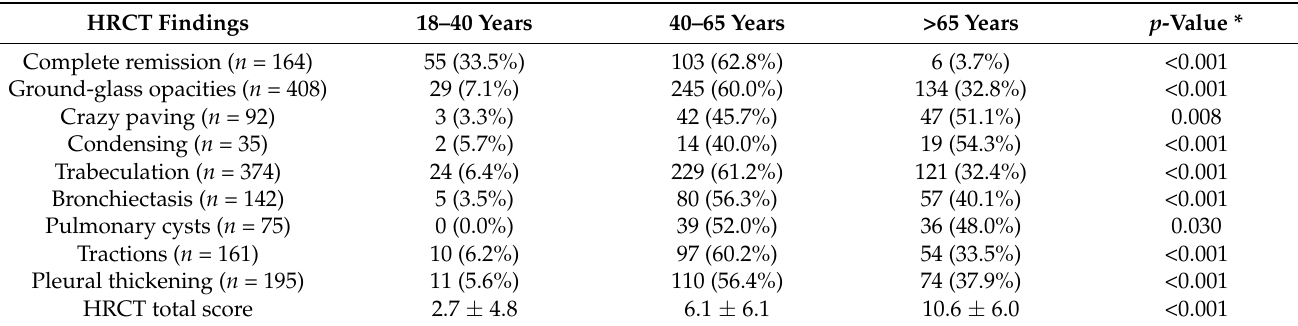
Table 4. Comparison of imagistic findings in the study cohort stratified by age group.